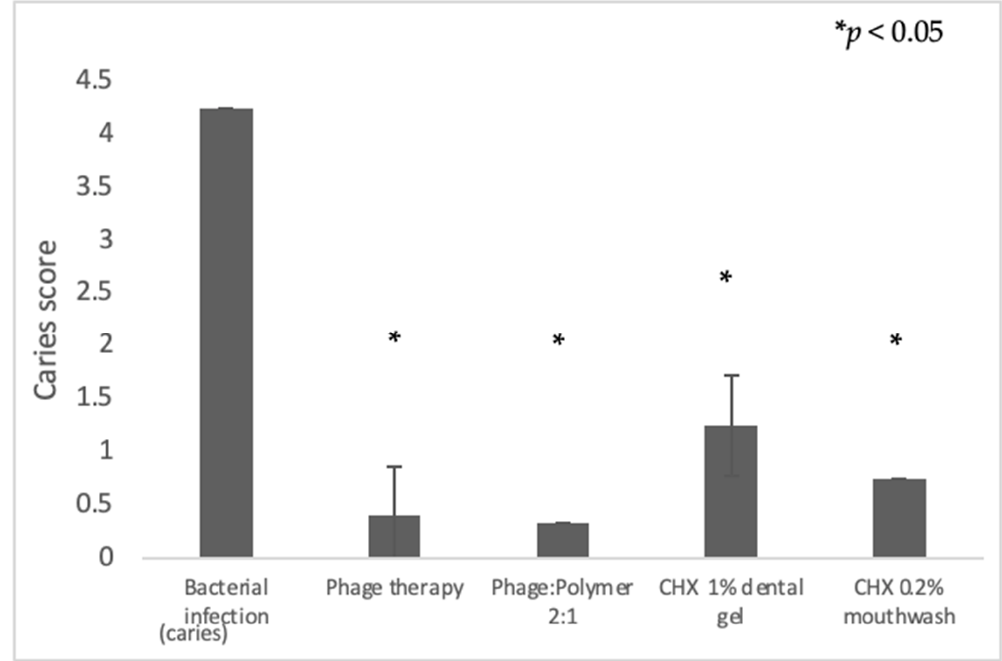
Figure 6. Caries scoring using hemi-sectioned molars. First mandibular molars were hemi-sectioned along the mesiodistal plane and photographed using SMZ25 stereoscope. Comparison of caries score: score increased significantly ( p = 0.011) in jaws infected with bacteria ( n = 5) compared to jaws treated with phages and CHX ( n = 5). Results are shown as mean ± SD based on five independent biological replicates.